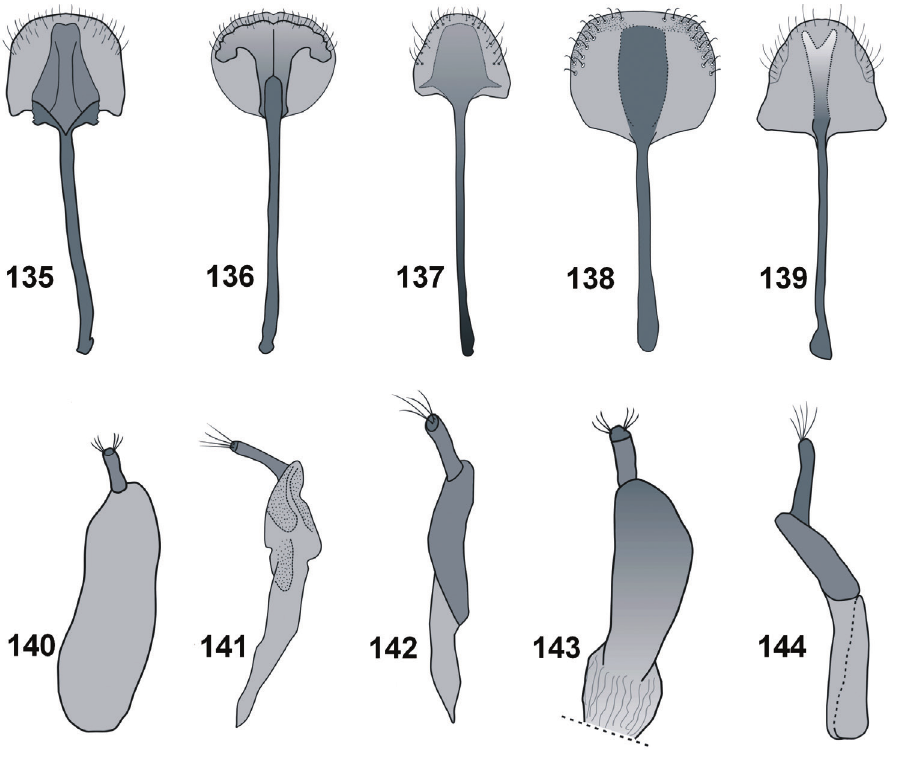
Figures 135–144. Female. Abdominal sternite VIII: 135 C. farinosus Perr. 136 C. malleus sp. n. 137 C. minimus sp. n. 138 C. szoltysi sp. n. 139 C. torosus sp. n. Ovipositor: 140 C. farinosus Perr. 141 C. malleus sp. n. 142 C. minimus sp. n. 143 C. szoltysi sp. n. 144 C. torosus sp.